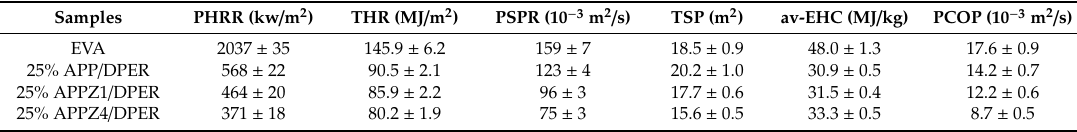
Figure 7. The heat release rate (HRR) ( a ), total release rate (THR) ( b ), smoke production rate (SPR) ( c ), mass loss curves ( d ), and the inset pictures in ( a – c ) were the digital photos of residual char of EVA composites from cone calorimeter. Table 4. The data from CCT of EVA composites. PHRR: peak of HRR, PSPR: peak SPR, TSP: total smoke production, PCOP: peak CO production rate of